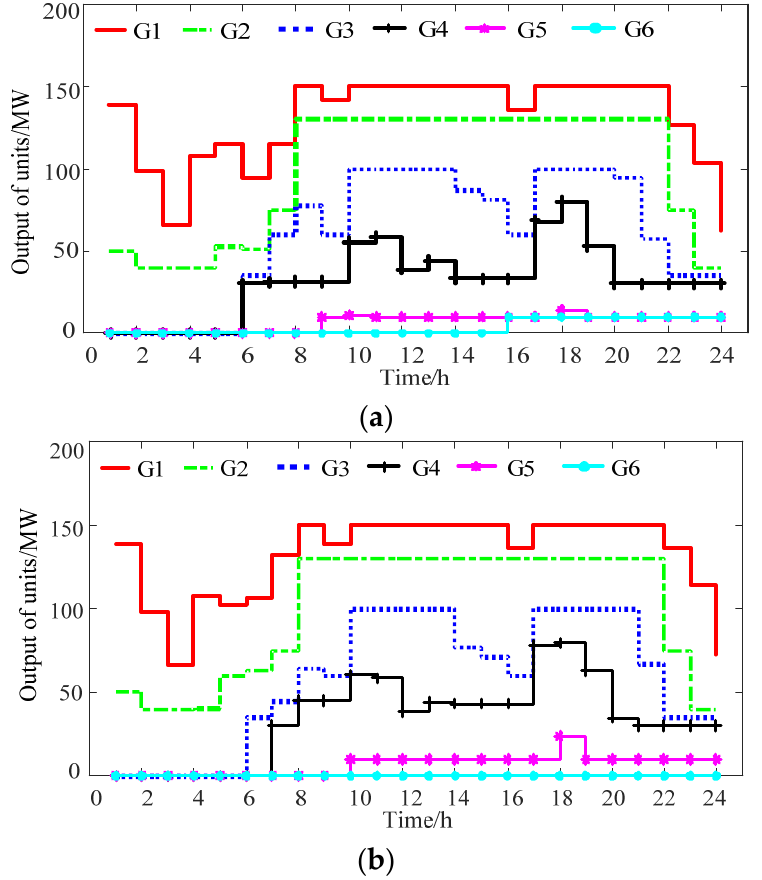
Figure 6. Power output of units in different Cases: ( a ) Case3; ( b ) Case4.